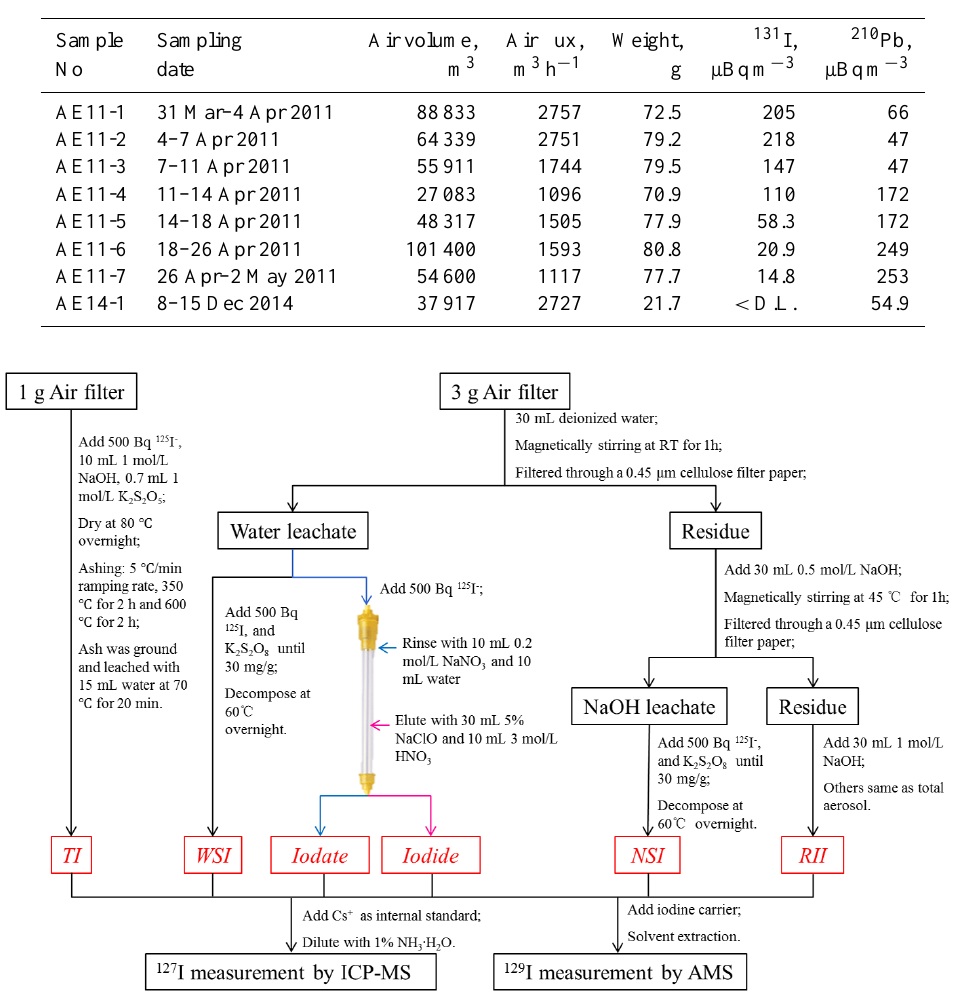
Figure 2. Schematic diagram of the analytical procedure for the determination of 127 I and 129 I species in aerosols (adapted from Zhang et al., 2015). TI for total iodine, WSI for water-soluble iodine, NSI for NaOH-soluble iodine and RII for residual-insoluble